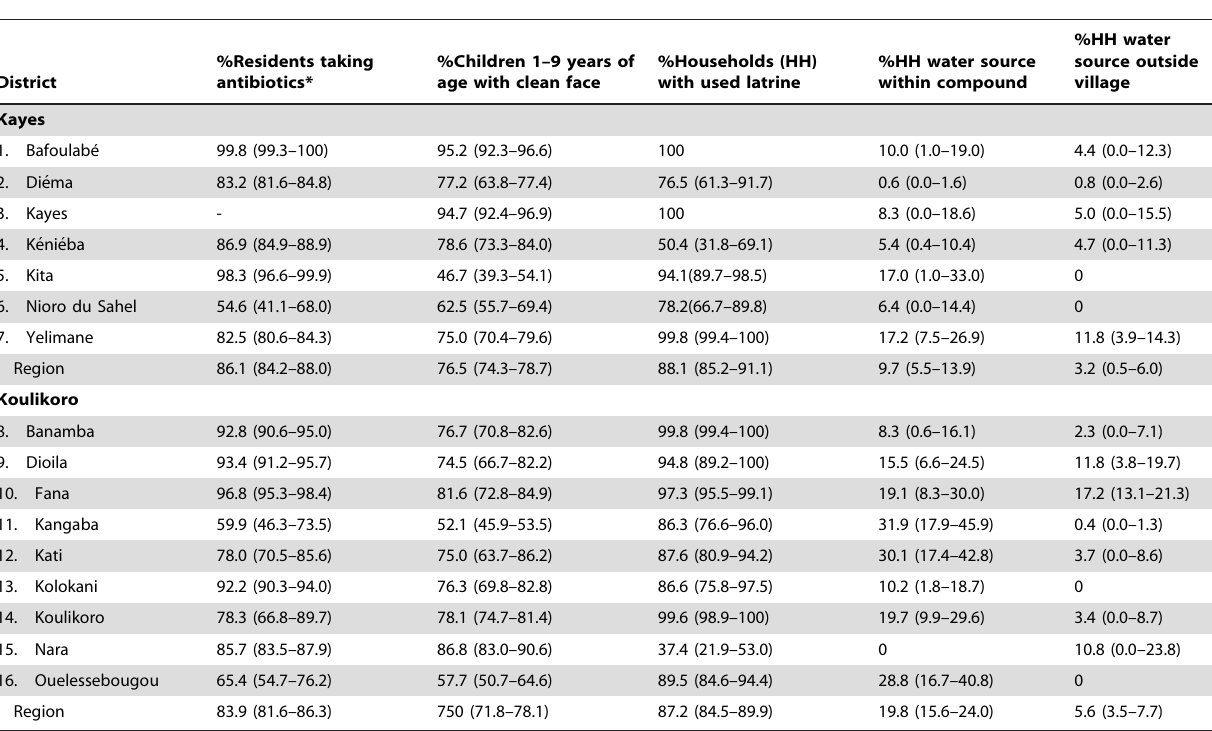
Table 4. Indicators of A, F and E uptake in Kayes and Koulikoro Regions, Mali 2009.